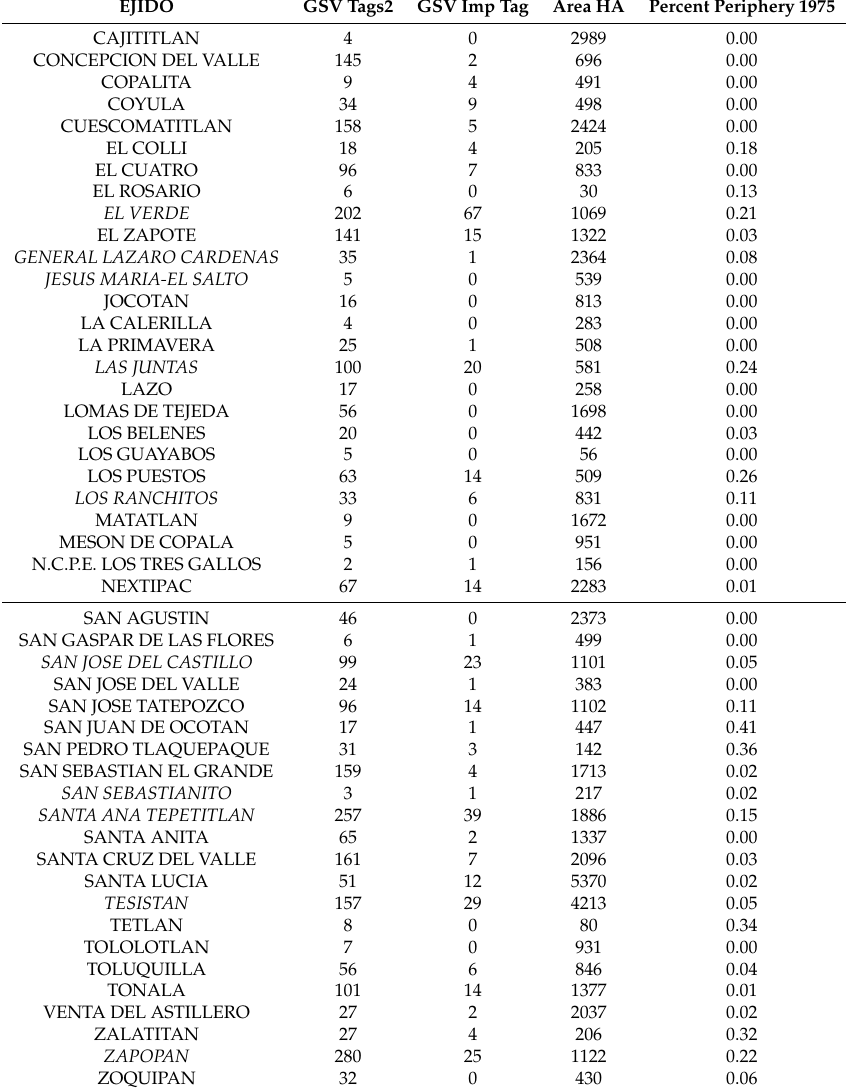
Table A1. Area of ejidos, area designated periphery, and GSV